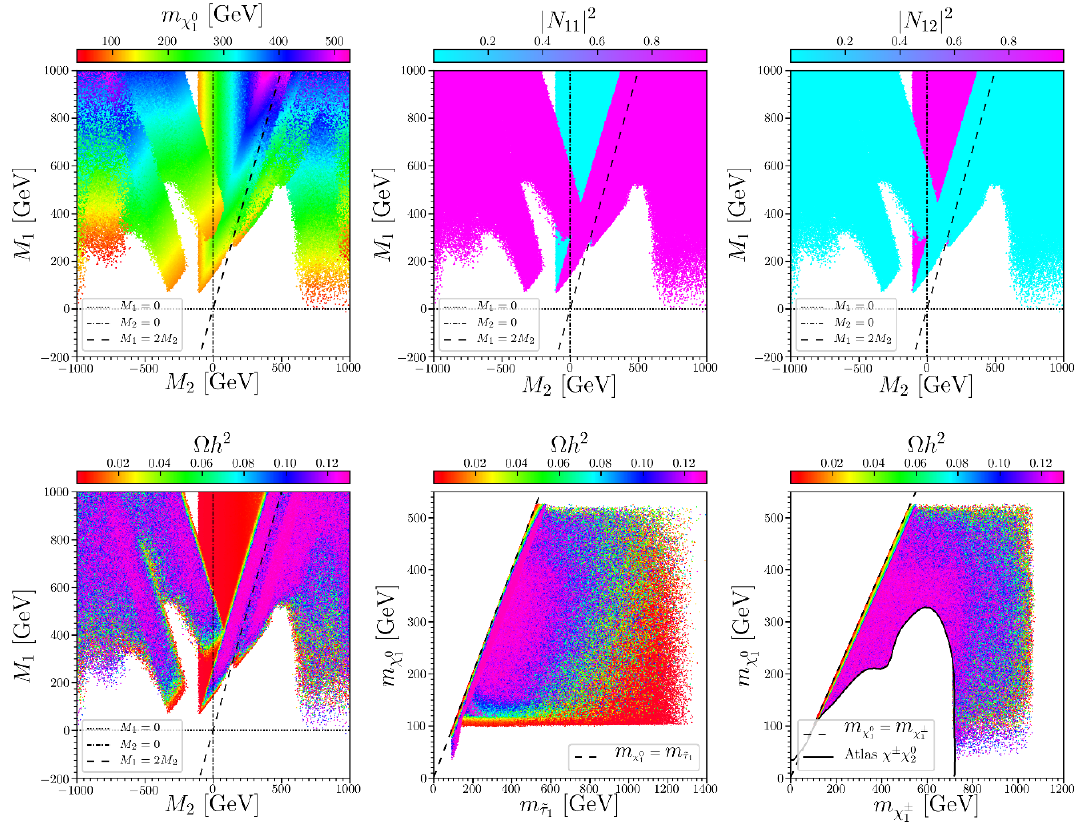
Figure 4 . Surviving samples in the M 1 versus M 2 (upper 3 and lower left, where M 1 ; 2 are both de(cid:12)ned at GUT scale), LSP dark matter mass m versus the lighter stau mass m ~ (cid:28) (lower middle), (cid:31) 0 1 1 and m versus the lighter chargino mass m (lower right) planes. Colors indicate m (upper left), (cid:31) 0 1 (cid:31) 0 1 (cid:31) (cid:6) 1 bino component in LSP (upper middle), wino component (upper right), and LSP relic density ((cid:10) h 2 ), respectively. In all these six 2-dimension planes, larger-(cid:10) h 2 samples are projected on top of smaller ones. In the lower right planes, the black solid curve indicate the constraint of searching for (cid:31) (cid:6) (cid:31) 0 2 associate production in (cid:12)nal states with tau leptons by Atlas collaboration at the 13 TeV LHC [128].